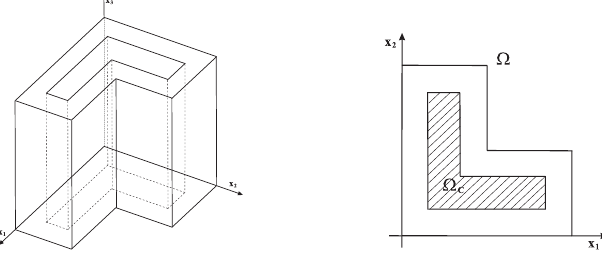
Figure 1. Sketch of the domain 3D (left) and 2D